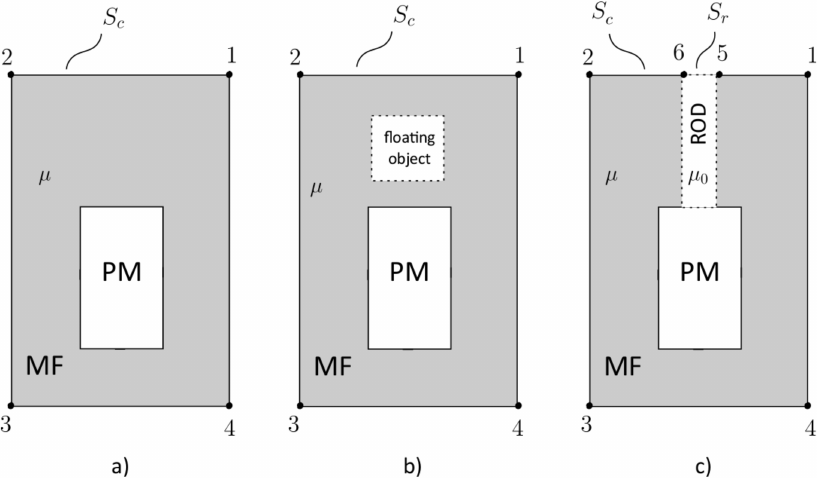
Figure 4. Magnetic levitation force calculated through the integration over the container surface: ( a , b ) The integration path is not affected by the object’s non-intersecting the surface over which it is integrated; ( c ) The integration path involving materials with different magnetic